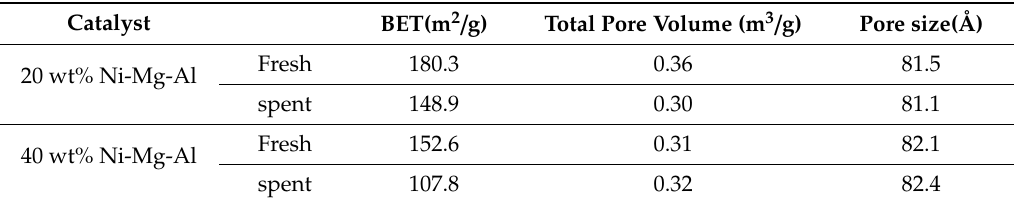
Table 2. Brunauer–Emmett–Teller (BET) surface area, pore volume, and pore size of 20 wt% Ni-Mg-Al catalyst (fresh and spent).